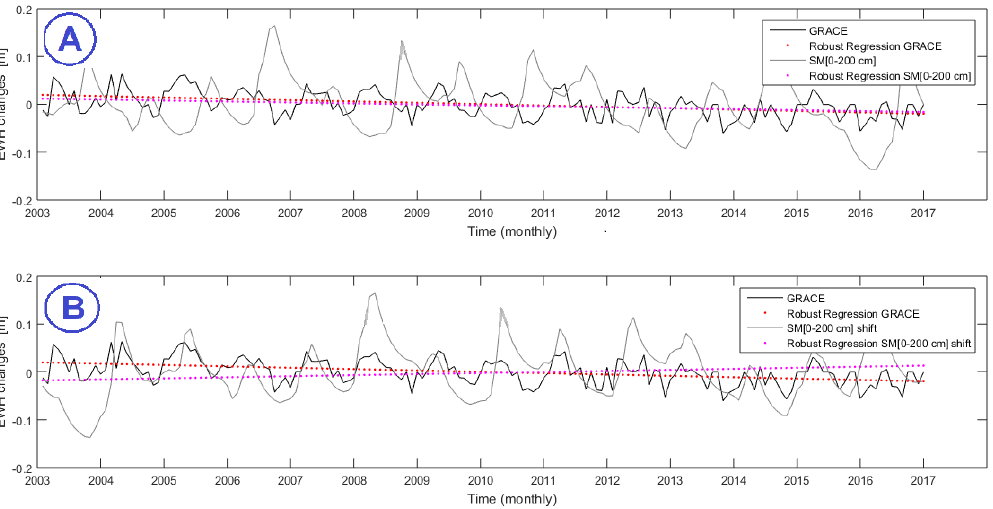
Figure 2 . A) Comparison of the soil moisture content variations from GLDAS with TWS variations from GRACE during 2003–2016 in Sarakhs catchment. SM denotes soil moisture in different depths (0 – 200 cm) from GLDAS. B) Alignment of two time series using cross correlation function (Time lag= -19).